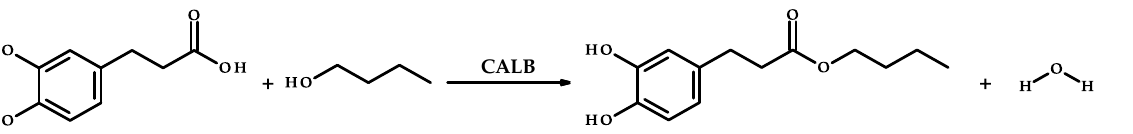
Figure 1. Chemical structures of ( a ) dihydrocaffeic acid and ( b ) dopamine.